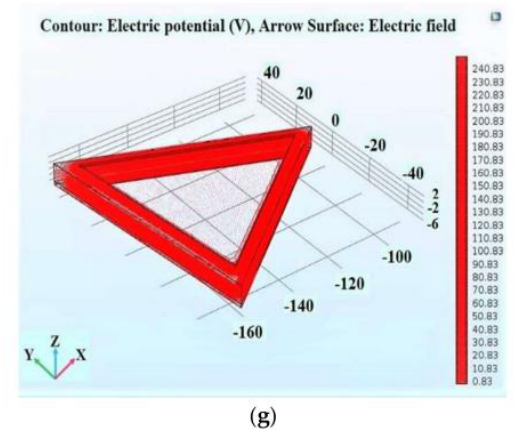
Figure 9. ( a ) Simulation of octagon plate geometry in COMSOL. ( b ) Simulation of heptagon plate geometry in COMSOL. ( c ) Simulation of hexagon plate geometry in COMSOL. ( d ) Simulation of circular plate geometry in COMSOL. ( e ) Simulation of pentagon plate geometry in COMSOL. ( f ) Simulation of rectangular plate geometry in COMSOL. ( g ) Simulation of triangular plate geometry in COMSOL.